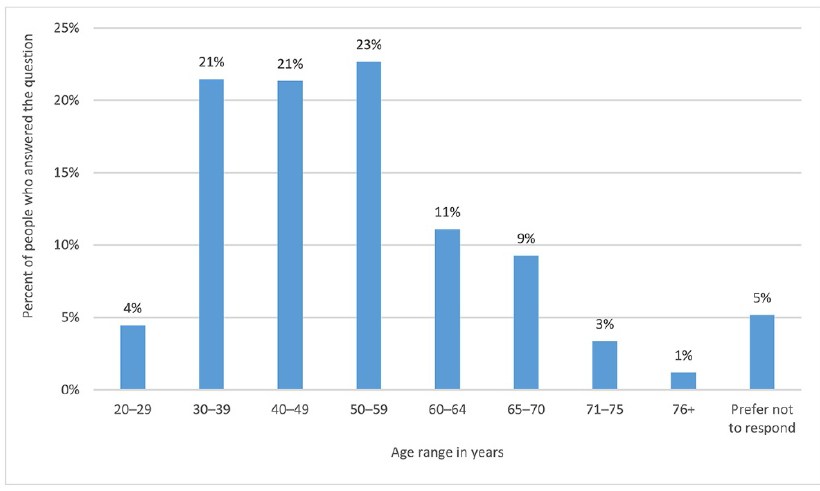
Figure 2 Age range by